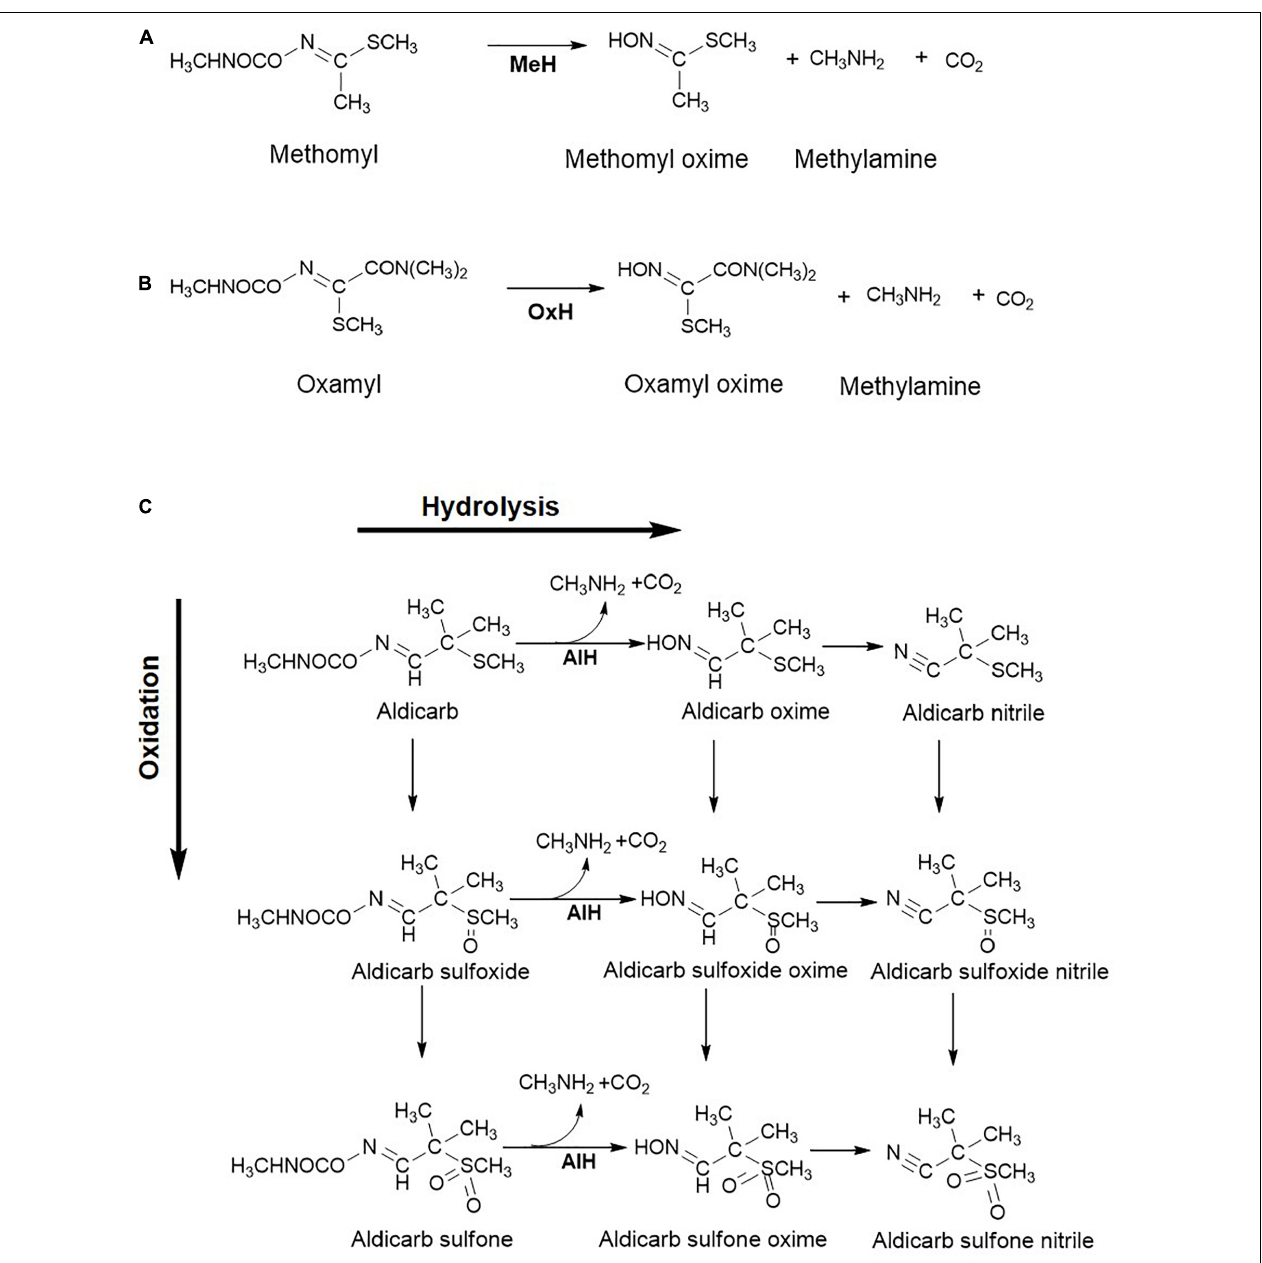
FIGURE 4 | Metabolic steps involved in the oxime-based carbamate pesticide degradation: (A) Methomyl; (B) Oxamyl; and (C) Aldicarb. Various enzymes reported for biotransformation are: Methomyl hydrolase, MeH; Oxamyl hydrolase, OxH; Aldicarb hydrolase, AlH. Metabolism of aldicarb involves the hydrolytic route which results in the formation of oximes and upon further dehydration to nitriles, the oxidative route results in the formation of sulfones via sulfoxides. Further, metabolic routes for these pesticides are not elucidated in